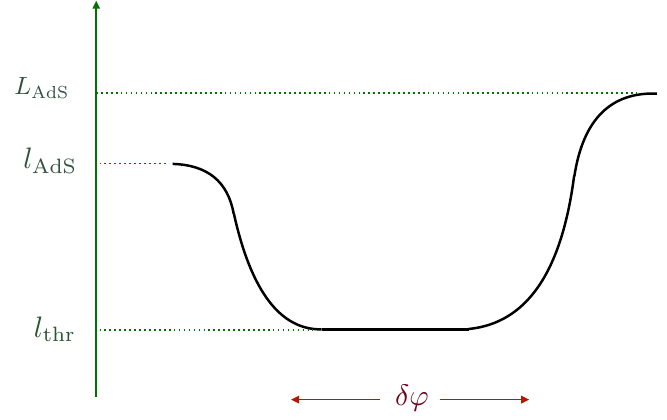
Figure 1 . Schematic plot of the Janus metric ds 2 vertical axes parametrize, respectively, the coordinate x and the radius ‘ ( x ) of the AdS 4 (cid:12)ber. The relevant parameters are the asymptotic left and right radii, l AdS and L AdS , the radius l thr of the throat, and the size of its (cid:13)at region (cid:14)x (cid:24) (cid:14)’ over which the string-theory dilaton varies